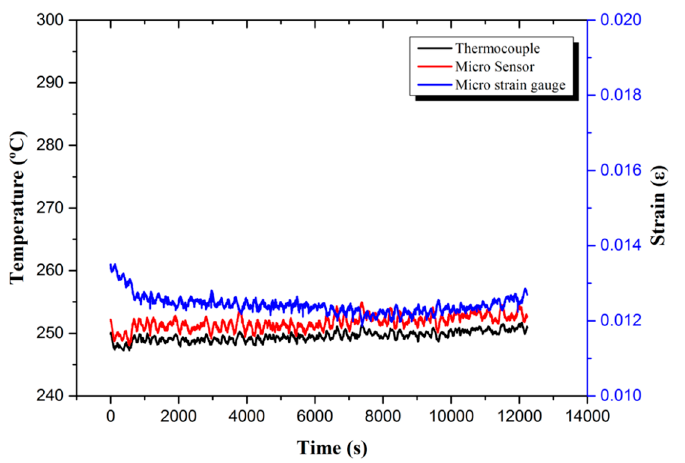
Figure 6. Real-time micro-monitoring data of temperature and strain of a single hydrogen absorp- tion reaction.